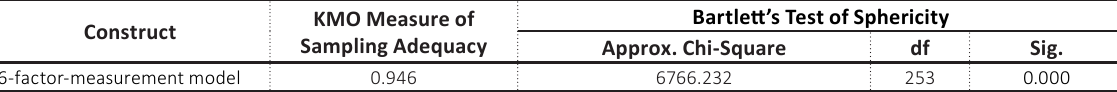
Table 2. Measuring sampling adequacy and Bartlett’s test of